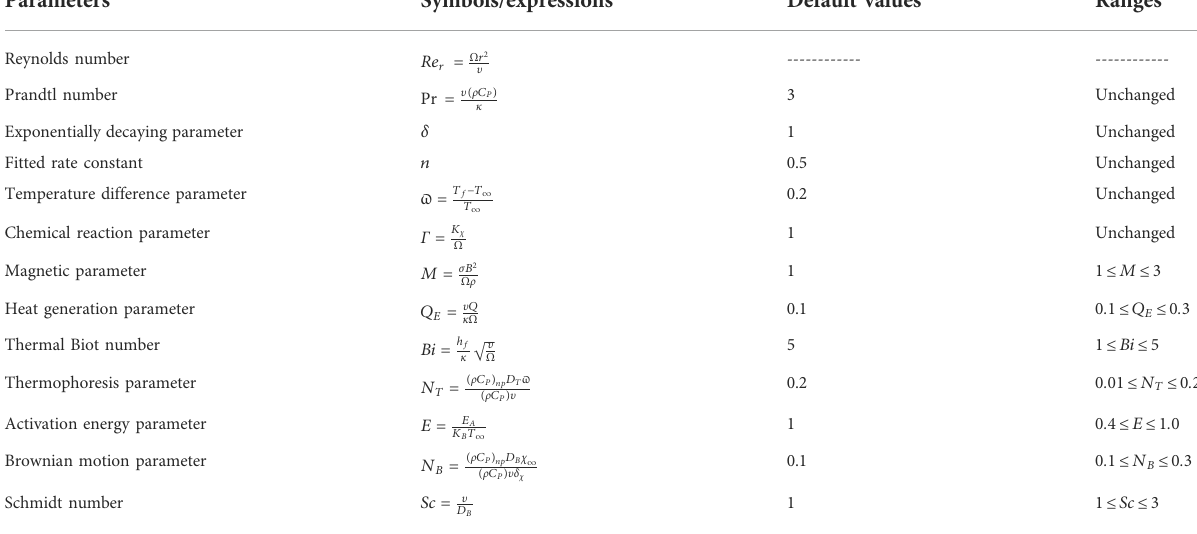
TABLE 1 Pertinent fl ow parameters and their characteristics. Parameters Symbols/expressions Default values Ranges